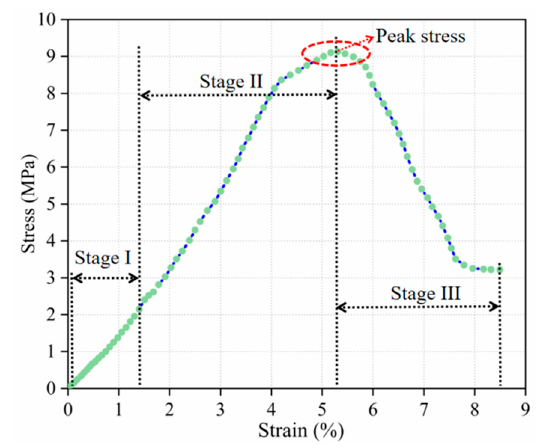
Figure 6. Measured stress–strain curve.